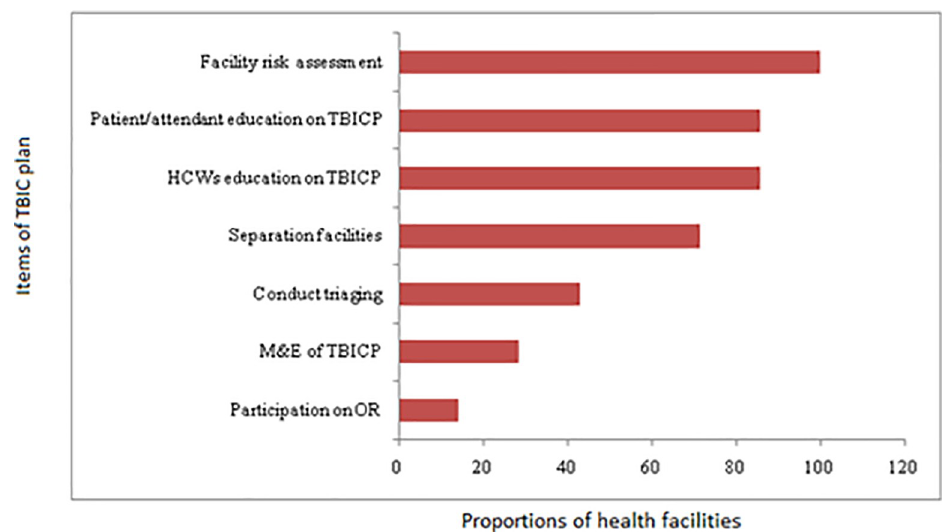
Fig 3. The proportion of health facilities with various items of TBIC plan in the Dale district, Sidama Zone, Southern Ethiopia.